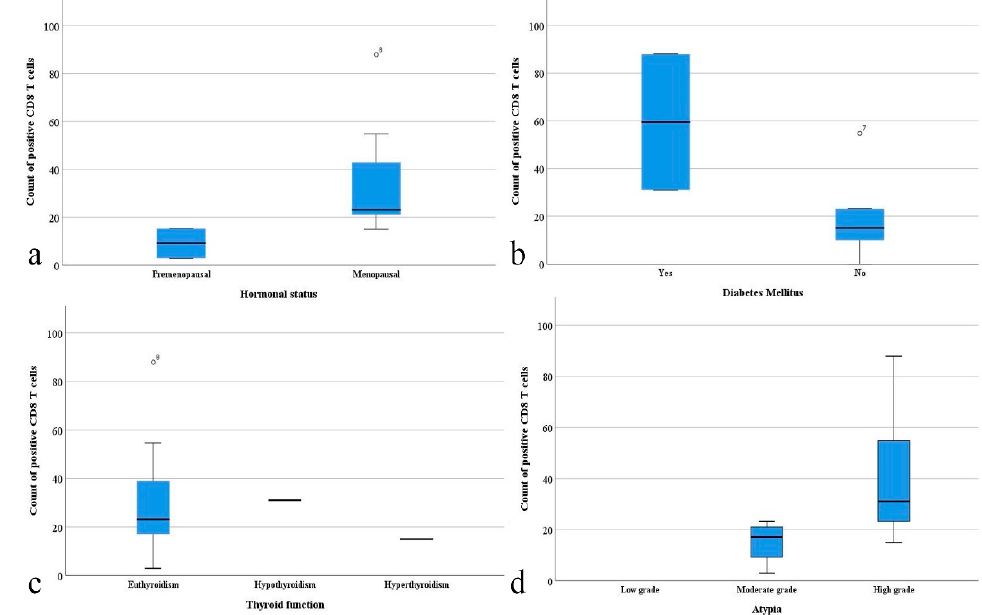
Figure 4. Correlations of the number of CD8 positive T cells with: ( a ) hormonal status; ( b ) diabetes mellitus; ( c ) thyroid function; ( d ) atypia. mellitus; ( c ) thyroid function; ( d )